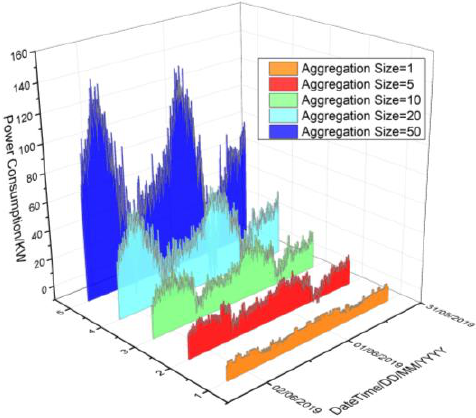
Figure 5. Single house power consumption versus different aggregation sizes of power consumption.